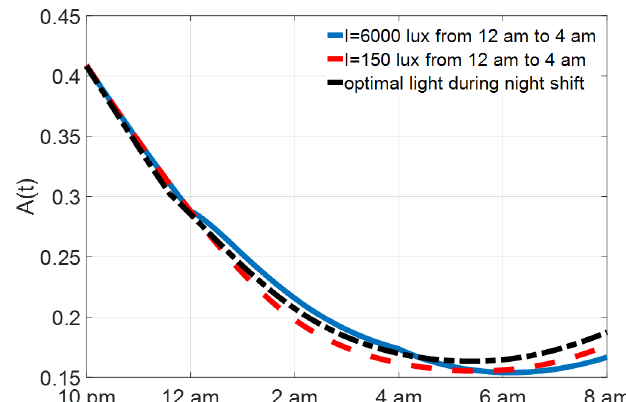
Figure 6. The alertness level of night-shift workers with light I = 6000 lux (blue solid line) and I = 150 lux (red dashed line) from 12 am to 4 am, and that with optimal light I ∗ ( t ) during the whole night-shift (black dashed line, solved by the algorithms in Section 3). The cumulative alertness values (and the average subjective alertness in VAS) of these three strategies are 2.21 (42.58 mm), 2.17 (42.24 mm), and 2.22 (42.60 mm),